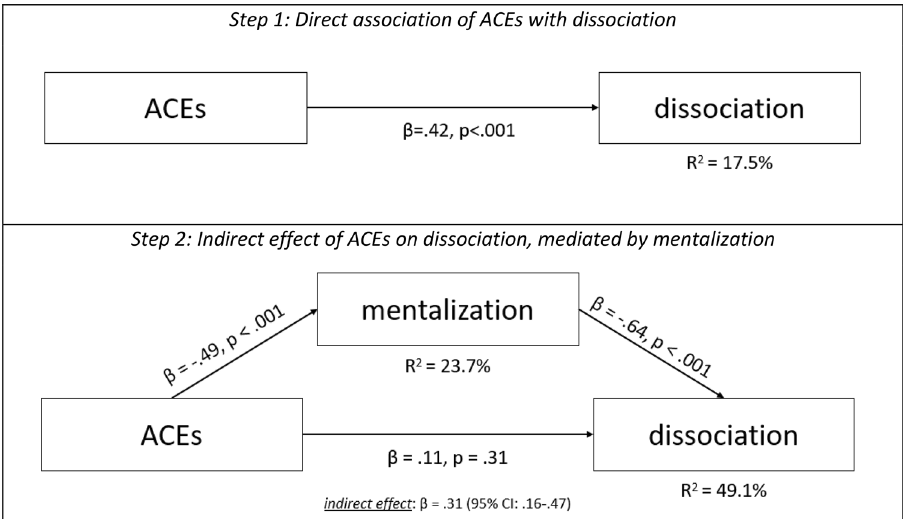
Figure 2. Mediation analysis of the direct and indirect association of ACEs with dissociation, mediated by mentalization. ACEs = Adverse childhood experiences, β = standardized coefficient; R2 = explained variance of the